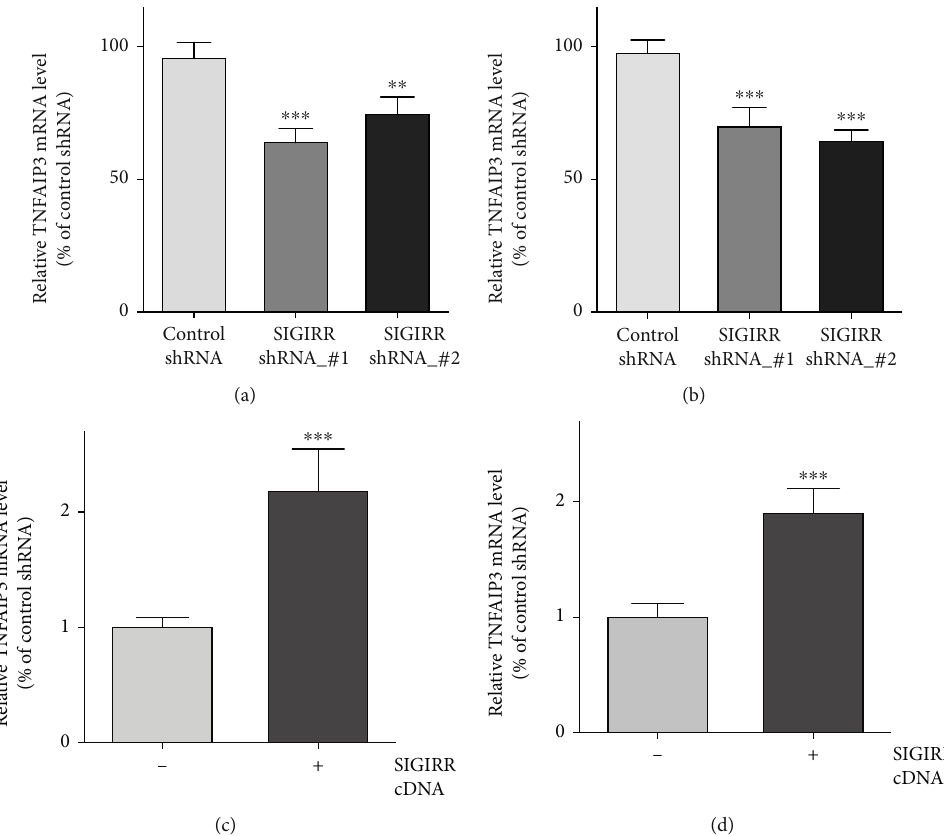
Figure 5: E ff ect of SIGIRR on TNFAIP3 expression both in AECs and in AMCs. (a, b) The TNFAIP3 mRNA levels both in AECs and in AMCs were evaluated after SIGIRR_shRNA transfection using the quantitative PCR assay. (c, d) TNFAIP3 mRNA levels were obviously enhanced both in AECs and in AMCs after SIGIRR overexpression by SIGIRR_cDNA application. The data represent two independent experiments with four mice per group. ∗∗ P < 0 : 01 and ∗∗∗ P < 0 : 001